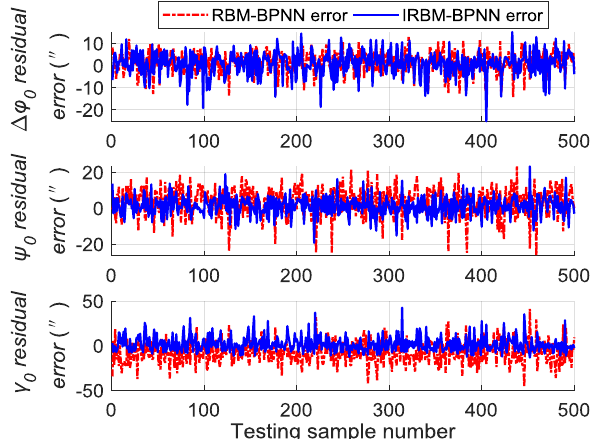
Figure 10. Contrast results of initial alignment residual error using RBM-BPNN and IRBM-BPNN method.